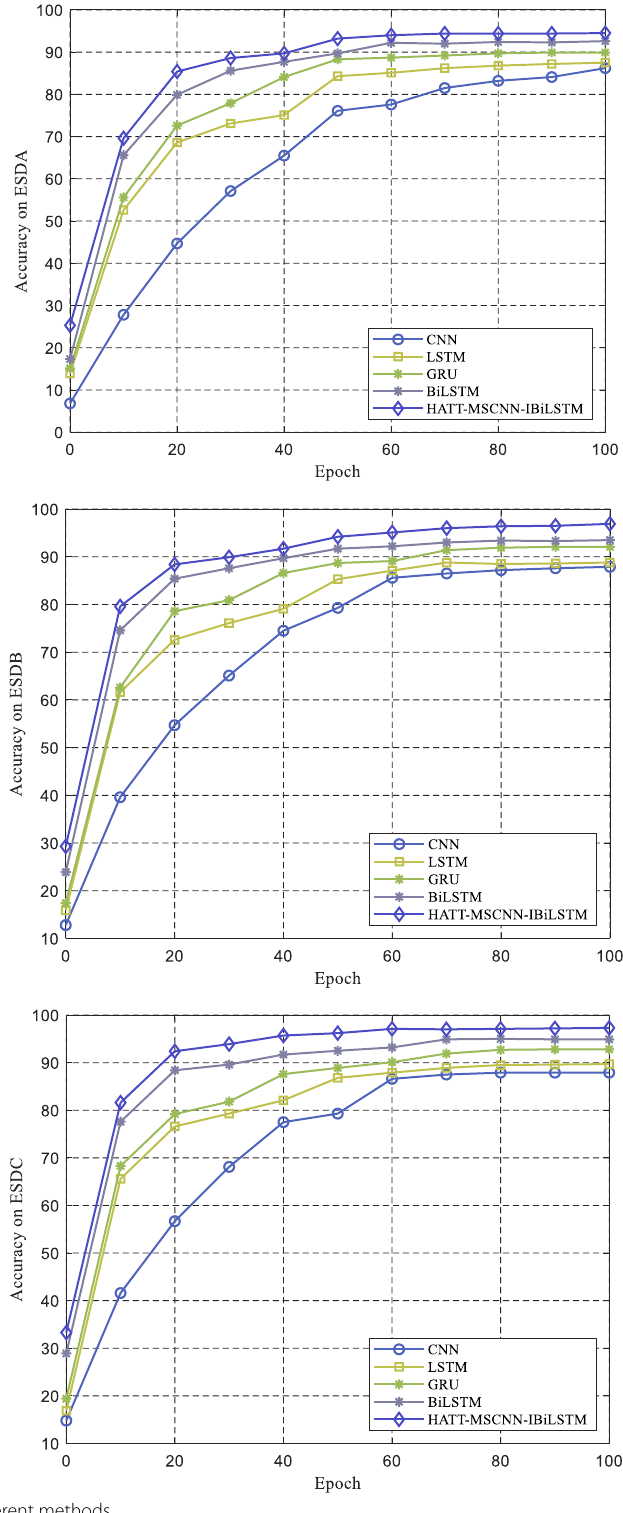
Fig. 12 Training accuracy for different